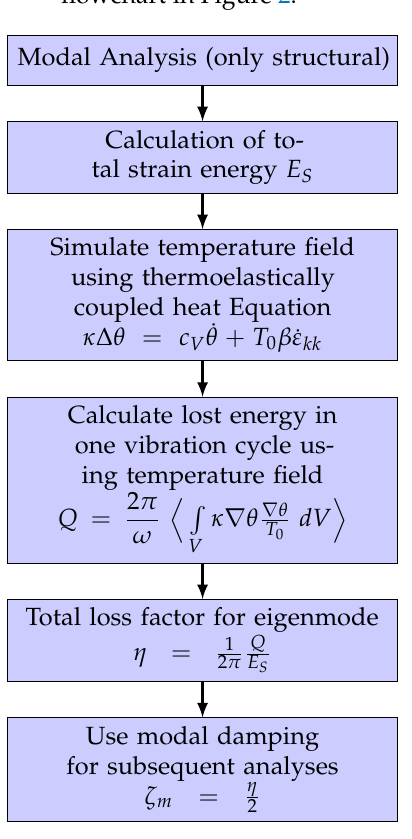
Figure 2. Flow chart for numerical solution